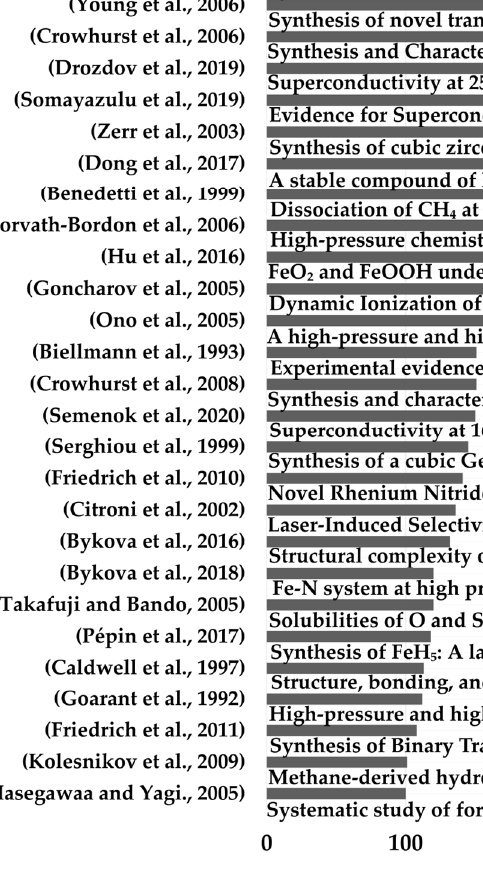
Figure 3. Most cited LRS-DAC works, with a minimum of 100 citations. Highly-cited topics included specific metal nitrides, metal hydrides related to superconductivity, and diamond synthesis [47–72].